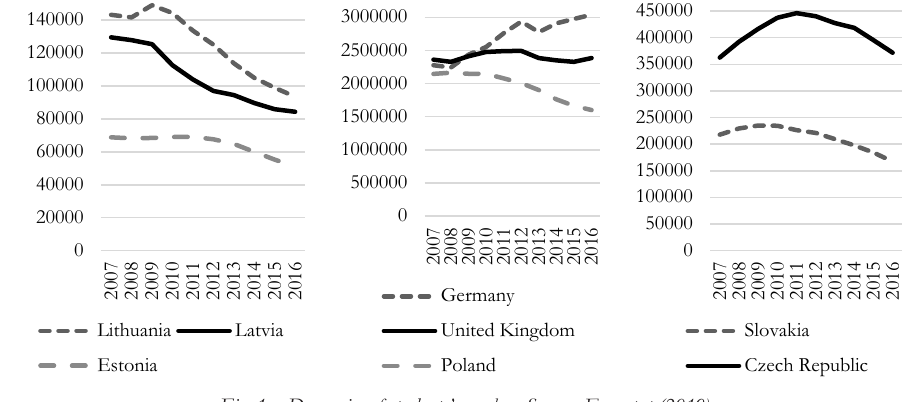
Fig. 1 – Dynamics of students’ number. Source: Eurostat